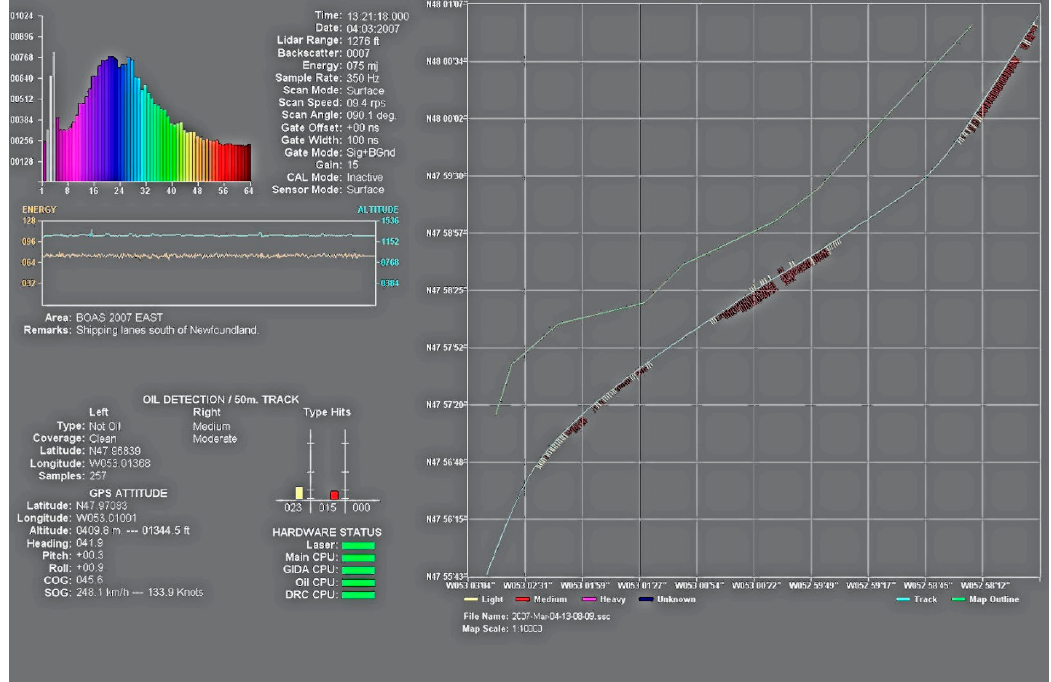
Figure 6. Operator’s monitor of the SLEAF system, showing sensor parameters and output map display (Environment Canada).